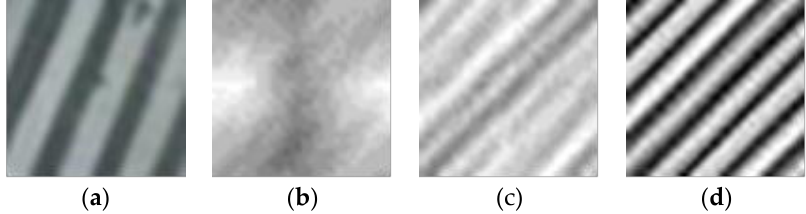
Figure 6. Gabor filtered images: ( a ) is the image after enhancement and ( b – d ) are the filtered images with the frequency of 2D Gabor filters set to 0.05, 0.08, 0.1, respectively with the direction θ = 135° . Because the spatial frequency and direction of zebra crossings are arbitrary in the images, three spatial frequency bands and four different directions are assumed based on prior knowledge to cover the spatial frequency and direction of zebra crossings. When the frequency of the filter matches with the spatial frequency of zebra crossing, the magnitude of the response will be large. We take the mean and standard deviation of the response energy in each direction at each spatial frequency as the texture feature. Figure 7 shows the contribution of the feature extracted by two groups of Gabor filters on 50 zebra crossing blocks and 50 background blocks, and the spatial frequency of zebra crossings is near 0.1. It is apparent that the segregation of features extracted by the filters with a frequency of 0.1 is much better than that of the others.